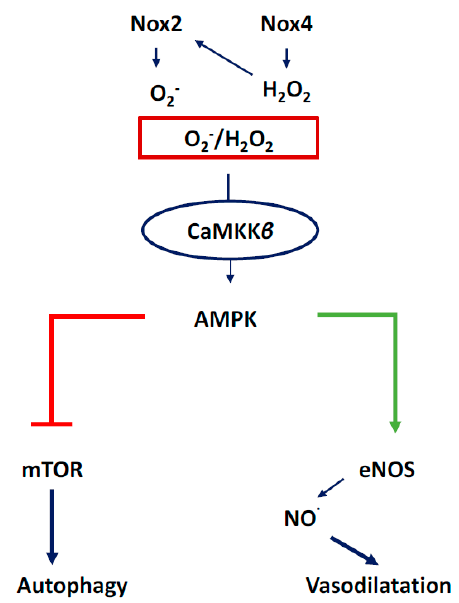
Figure 11. ROS-induced activation of CaMKK β , AMPK, and downstream activation of eNOS and the inhibition of mTOR. AMPK-mediated activation of eNOS results in NO-mediated vasodilation of coronary vessels, while AMPK-mediated inhibition of mTOR induces autophagy to dispose of cellular debris and recycle sub-cellular components for cell survival.